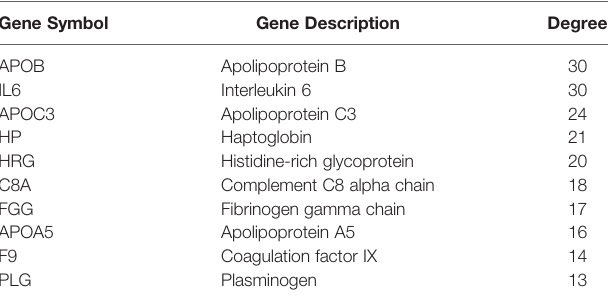
TABLE 1 | Top 10 Hub Genes With Higher Degree Of Connectivity. Gene Symbol Gene